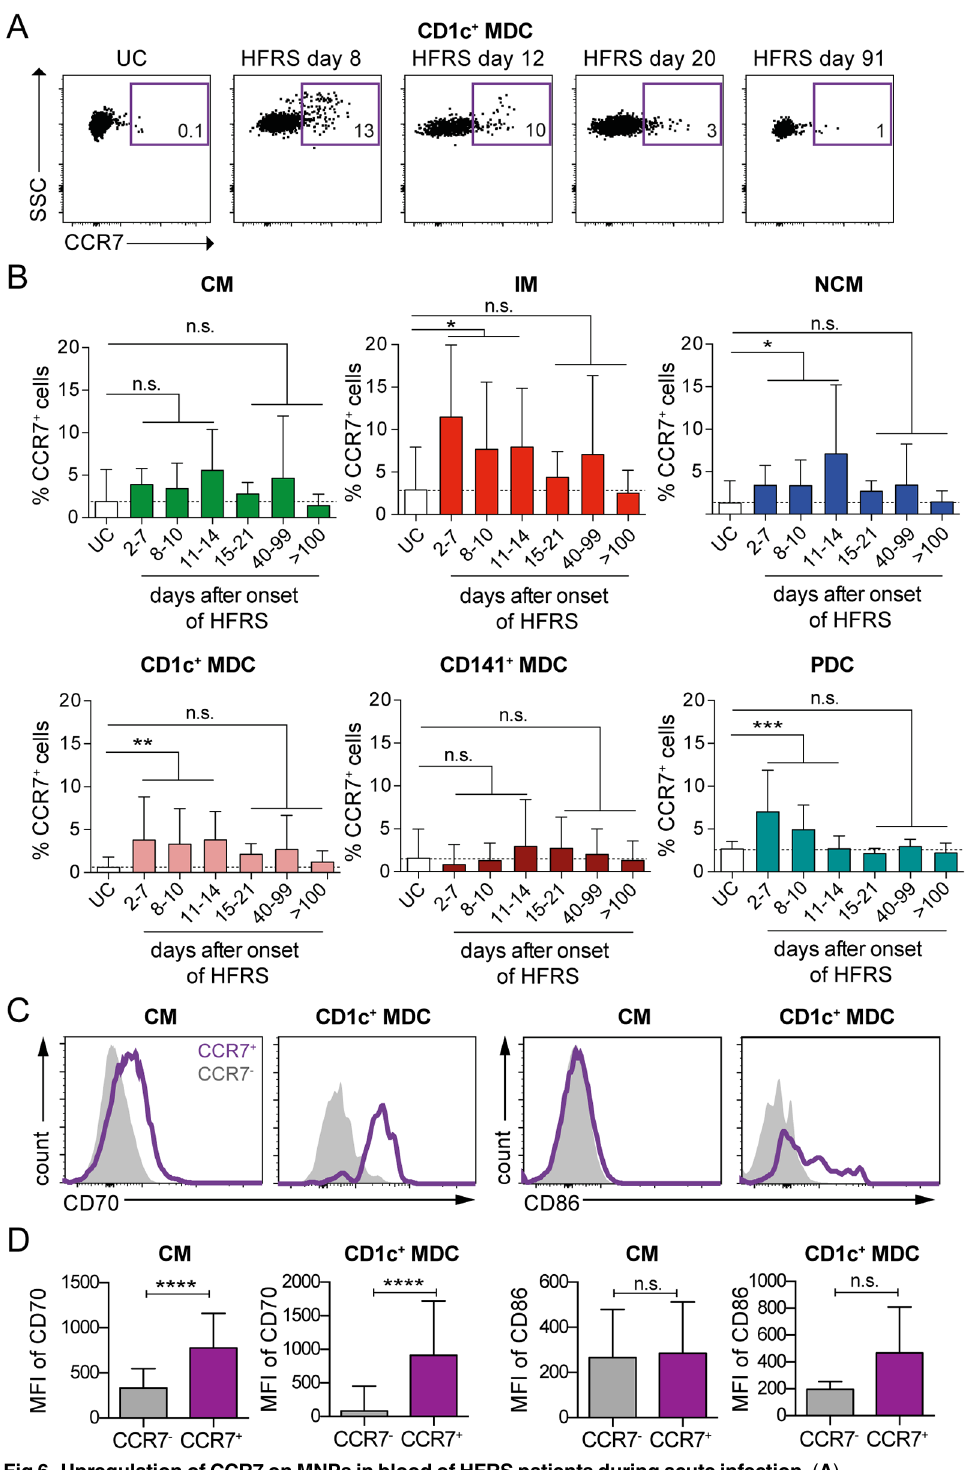
Fig 6. Upregulation of CCR7 on MNPs in blood of HFRS patients during acute infection. ( A ) Representative flow cytometry plots showingCCR7 expressionon CD1c + MDCs from one representative UC and one HFRS patient are shown. ( B ) Mean ± SDfrequenciesof CCR7 + CMs (green), IM (red), NCM (blue), CD1c + MDCs (coral), CD141 + MDCs (maroon) and PDCs (teal) were quantified in longitudinalsamples from HFRS patients in comparisonto UC. ( C ) Histograms indicateupregulation of CD70 on CM, and upregulation of